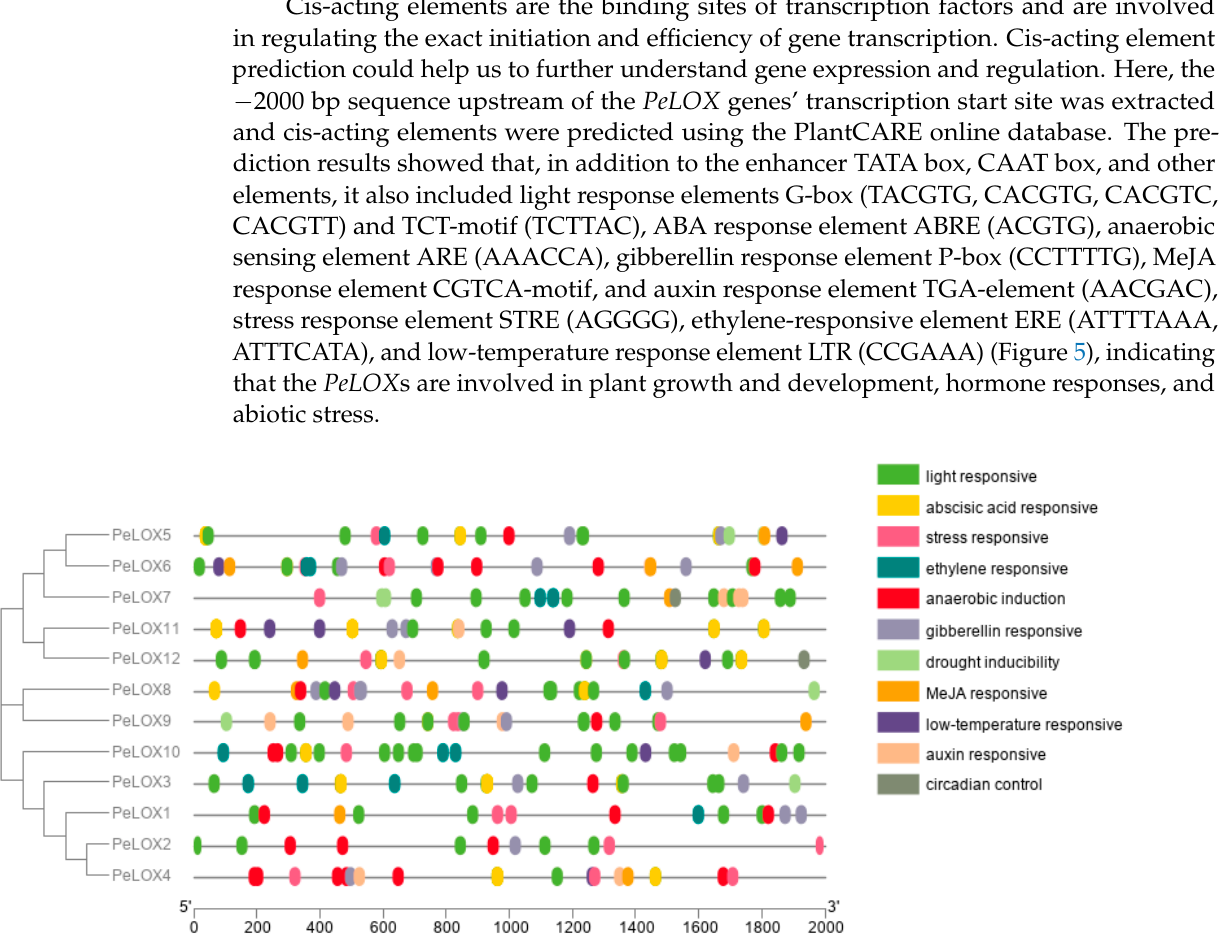
Figure 5. Cis-elements that are related to different stress and hormone in the putative promoters of